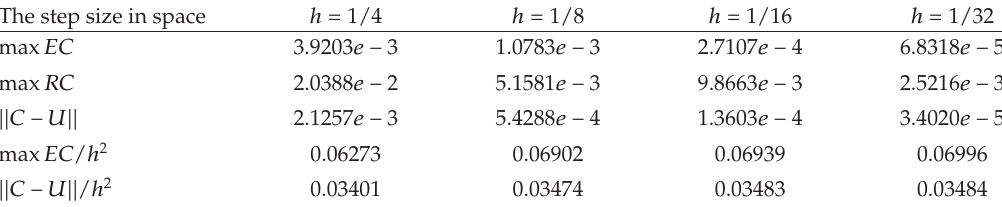
Table 1: The comparison of maximum absolute error, maximum relative error, and L 2 error when Δ t (cid:9) h . The step size in